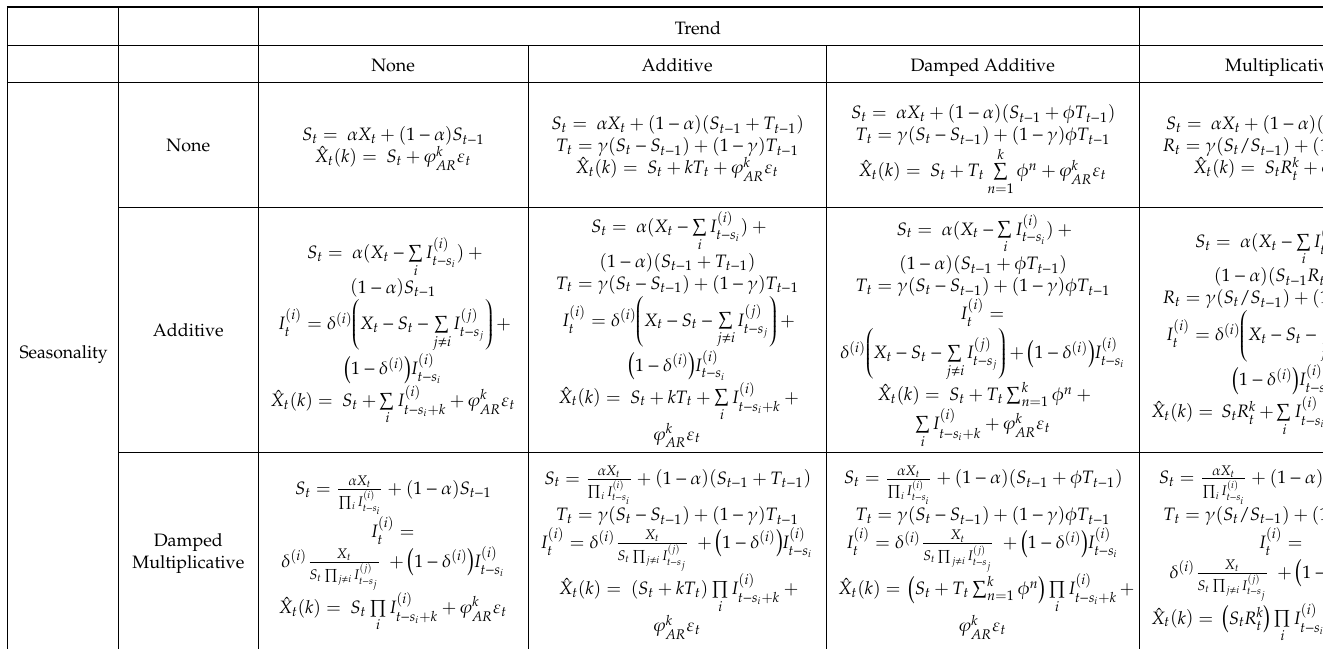
Table A1. Multiple seasonal methods